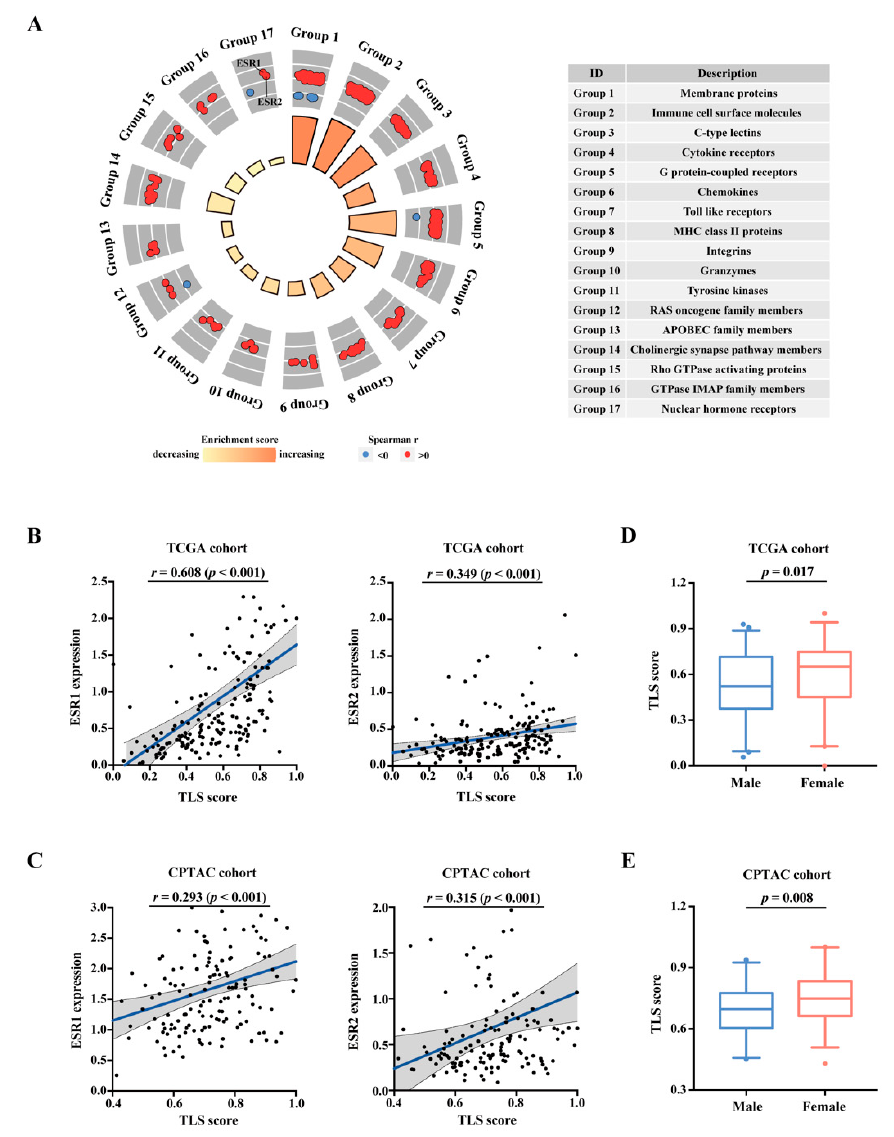
Figure 1. Association between estrogen signaling and TLS scores in two public databases. ( A ) Circular plot showing gene categories significantly correlated with TLS score; the inner circle displays the gene number and enrichment score in each group; the outer circle displays the scatter plots of spearman’s r-values of gene members. ( B ) Scatter plots of the positive correlation between TLS score and ESR1 and ESR2 expression in the TCGA cohort ( n = 178). ( C ) Scatter plots of the positive correlation between TLS score and ESR1 and ESR2 expression in the CPTAC cohort ( n = 141). ( D ) Comparison of TLS scores between males and females in the TCGA cohort ( n = 178). ( E ) Comparison of TLS scores between males and females in the TCGA cohort ( n = 141).